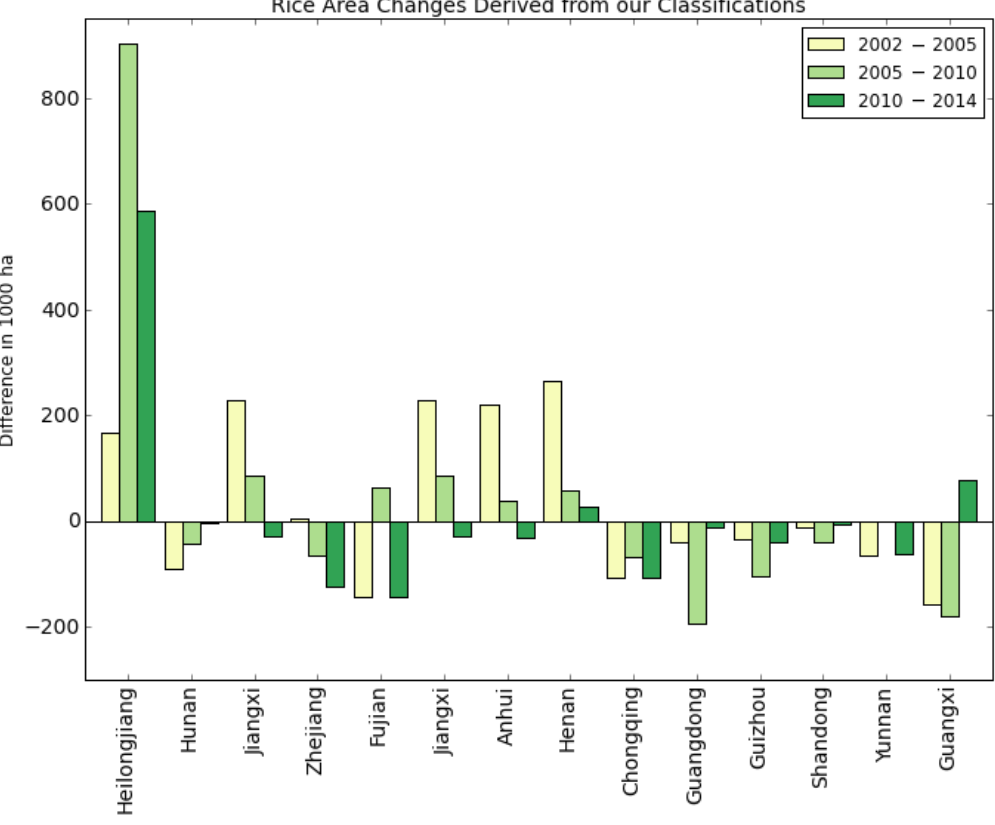
Figure 7. Provincial rice area changes from 2002–2014.